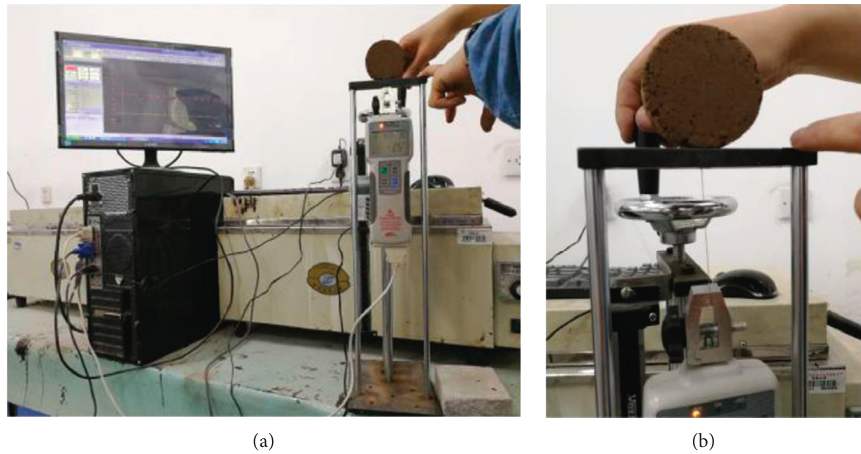
Figure 5: Operating process of the pull-out experiment. (a). Digital force gauge. (b). Root